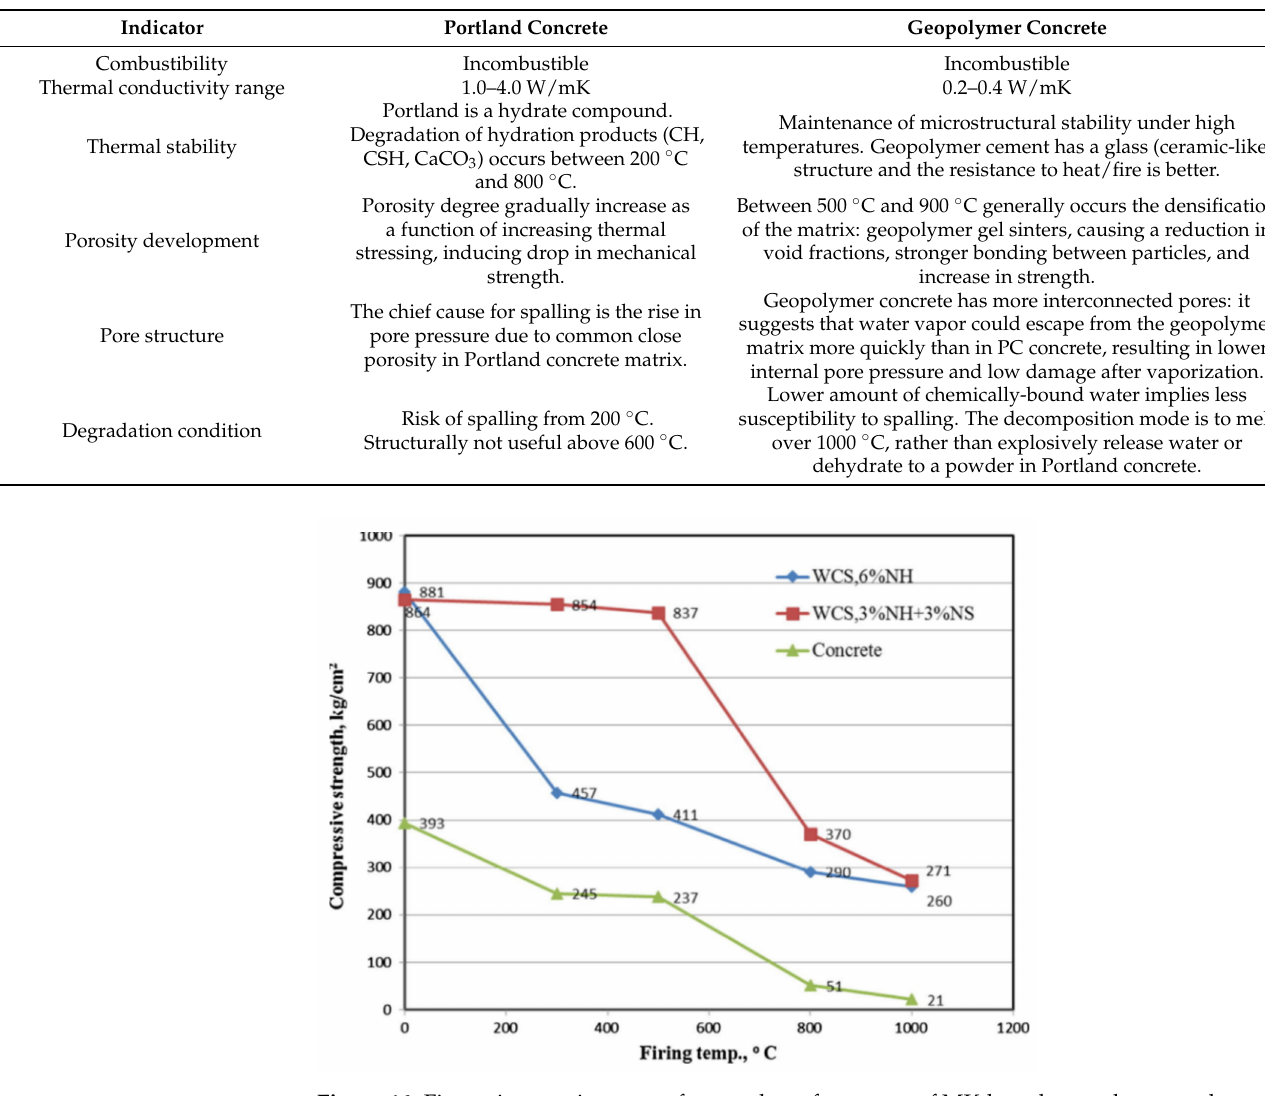
Figure 16. Fire resistance, in terms of strength performance, of MK-based geopolymer and conven- tional concretes. Reprinted with permission from Ref. [97]. Copyright 2018